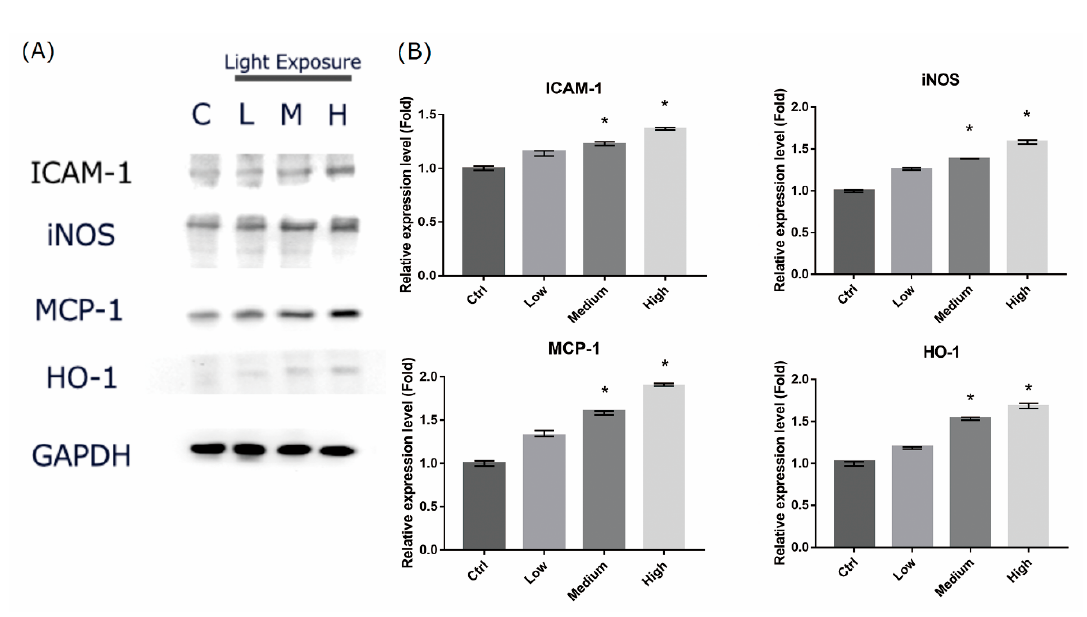
Figure 6. Liquid crystal display (LCD) exposure increases oxidative stress and inflammatory-related protein expression levels in 661W cells. ( A ) Evaluation of the protein expression of enzymes associated with inflammatory response by western blot analysis. 661W cells were exposed to LCD with low, medium, and high ocular energy exposure index (OEEI) for 3 days. GAPDH was used as the internal control. C: control group, no light exposure; L: low, M: medium, H: high OEEI. ( B ) Relative expression of intercellular adhesion molecule 1 (ICAM-1), inducible nitric oxide synthase (iNOS), monocyte chemoattractant protein 1 (MCP-1), and heme oxygenase-1 (HO-1). Ctrl: control group, no light exposure; All data represent the median and the interquartile range. * p < 0.05 compared to the control group by Kurskal-Wallis test with post hoc Dunn test; n = 5 per